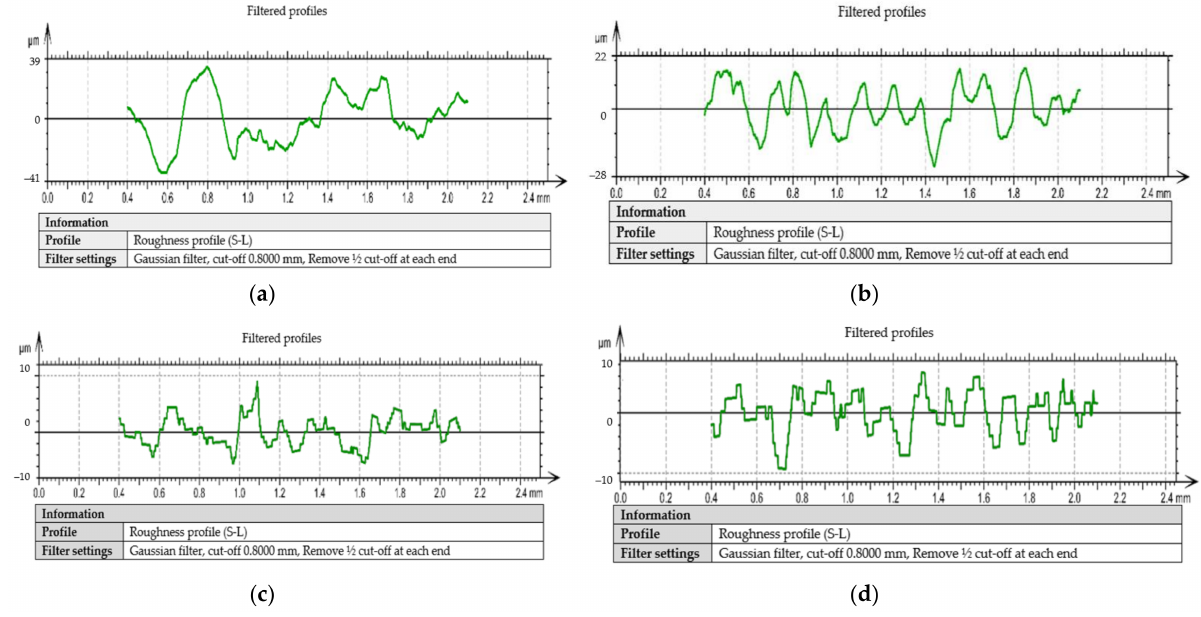
Figure 11. Filtered profiles: ( a ) in case of machining with the cutting tool T01 to the outside; ( b ) in case of machining with a T01 cutting tool inwards; ( c ) in case of machining with a T02 cutting tool to the outside; ( d ) in case of machining with a T02 cutting tool